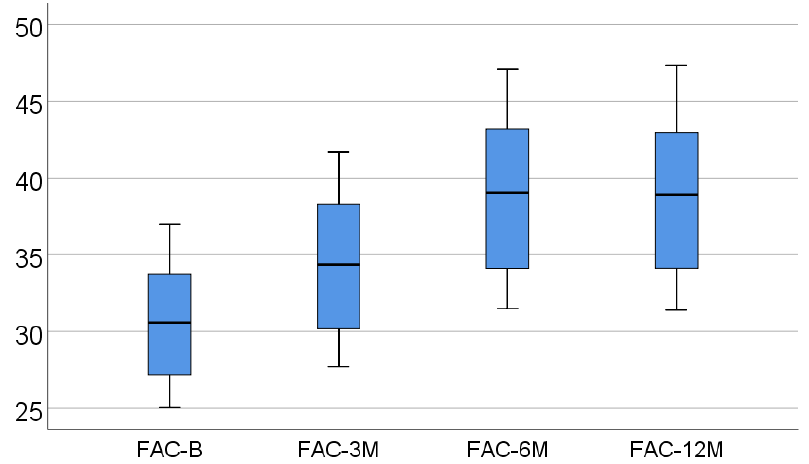
Figure 2. Box-plot representation of FAC evolution.